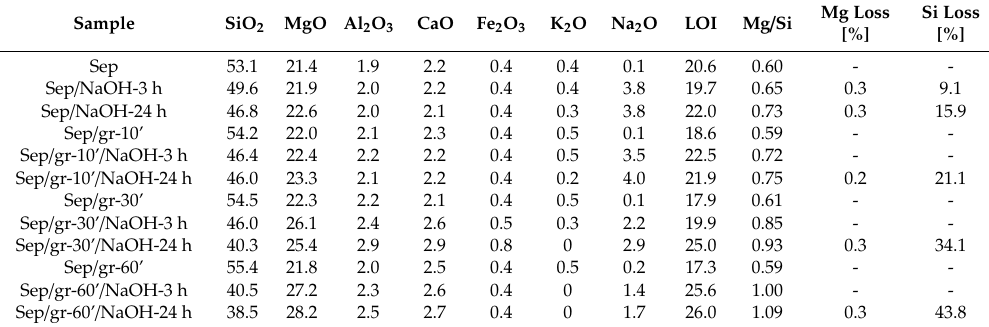
Table 1. EDX-determined chemical composition of selected samples (wt.% of metal oxides and loss on ignition), Mg / Si atomic ratio in the solids, amount of leached Mg and Si (as per cent of the initial content in the parent sample). (LOI—loss on